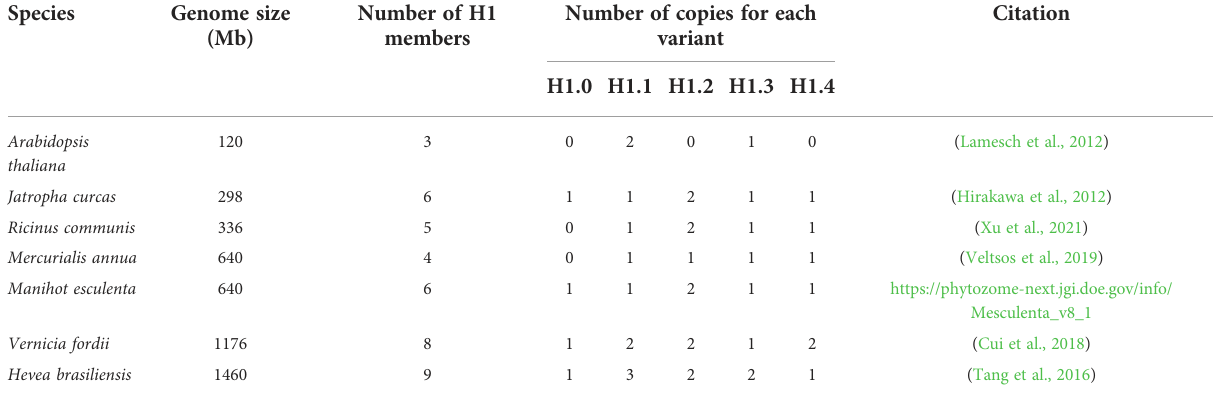
TABLE 2 Genome size and number of H1 variants and members in the seven species. Species Genome size Number of H1 (Mb)